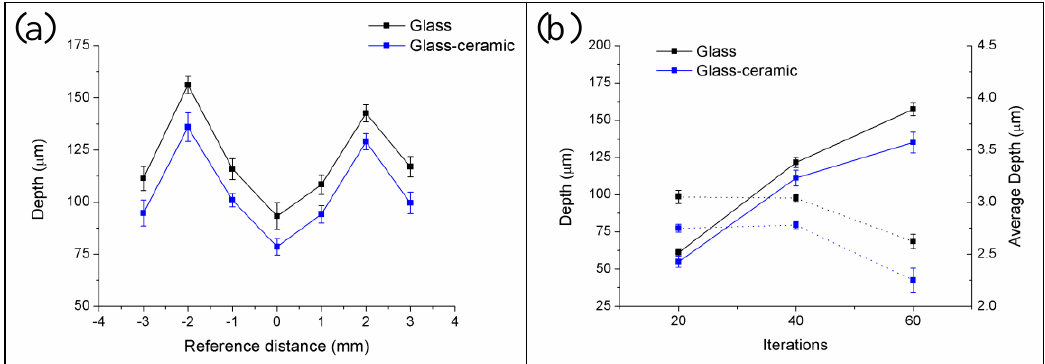
Figure 2. Machined depth achieved for the W-TCP eutectic glass and glass-ceramic samples around the focal plane (cero position) for 60 iterations ( a ) and machined depth (solid lines) and mean average depth (dotted lines) as a function of the number of iterations ( b ).